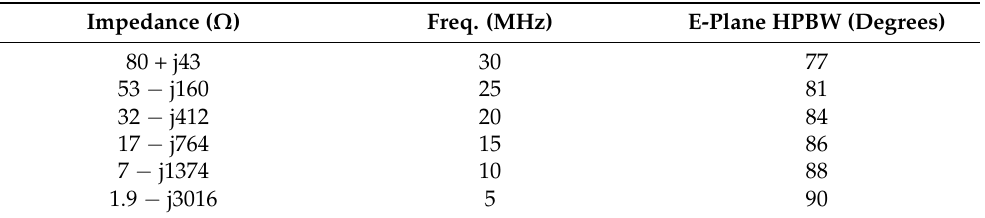
Table 1. Free space impedance of the array’s driven elements and HPBW as simulated by Eznec. Impedance ( Ω ) Freq. (MHz) E-Plane HPBW (Degrees) 80 +